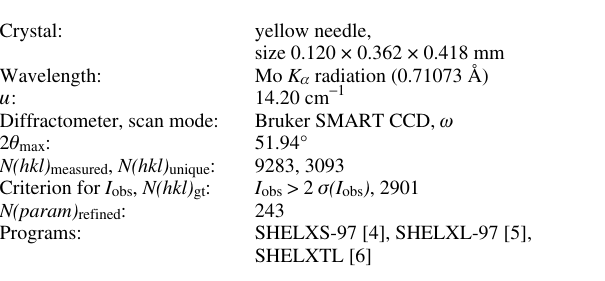
Table 1. Data collection and